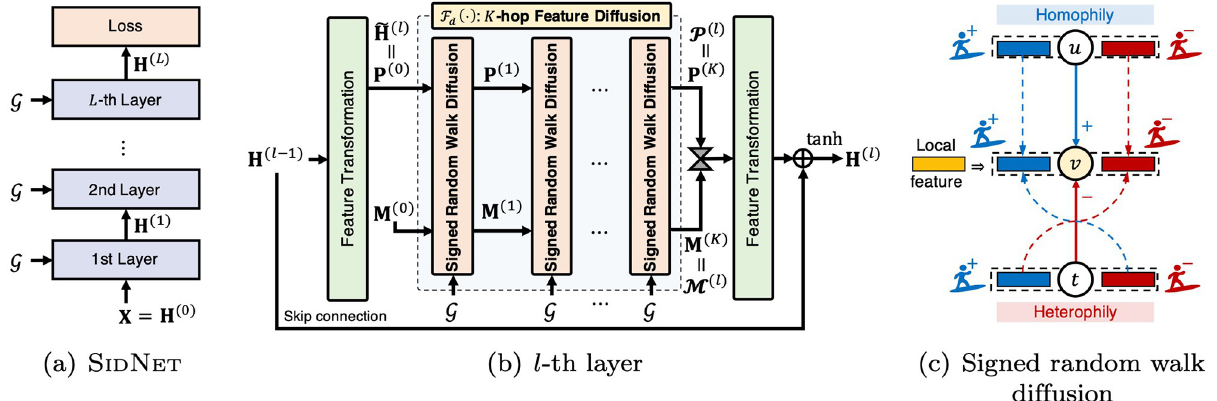
Fig 1. Overall architecture of S ID N ET . (a) Given a signed graph G and initial node features X , S ID N ET with multiple layers produces the final embeddings H ( L ) , which is fed to a loss function under an end-to-end framework. (b) A single layer learns node embeddings based on K -hop signed random walk diffusions of F ð�Þ . (c) Our diffusion module aggregates the features of node v so that they are similar to those connected by + edges (e.g., d node u ), and different from those connected by − edges (e.g., node t ). Also, it injects the local feature (i.e., the input feature of each module) of node v at each aggregation to make the aggregated features